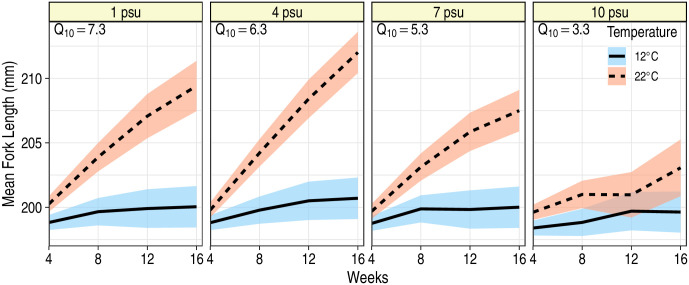
Mean fork length of juvenile blue catfish during a 16 week period at two temperatures and four salinities.Ribbons represent 95% confidence bands around the predicted mean fork lengths. Predictions are for a fish that was 198 mm at the start of the experiment (i.e., at week 0). For each salinity, Q10 estimates, assuming linear growth, are provided at the top left corner of each panel.